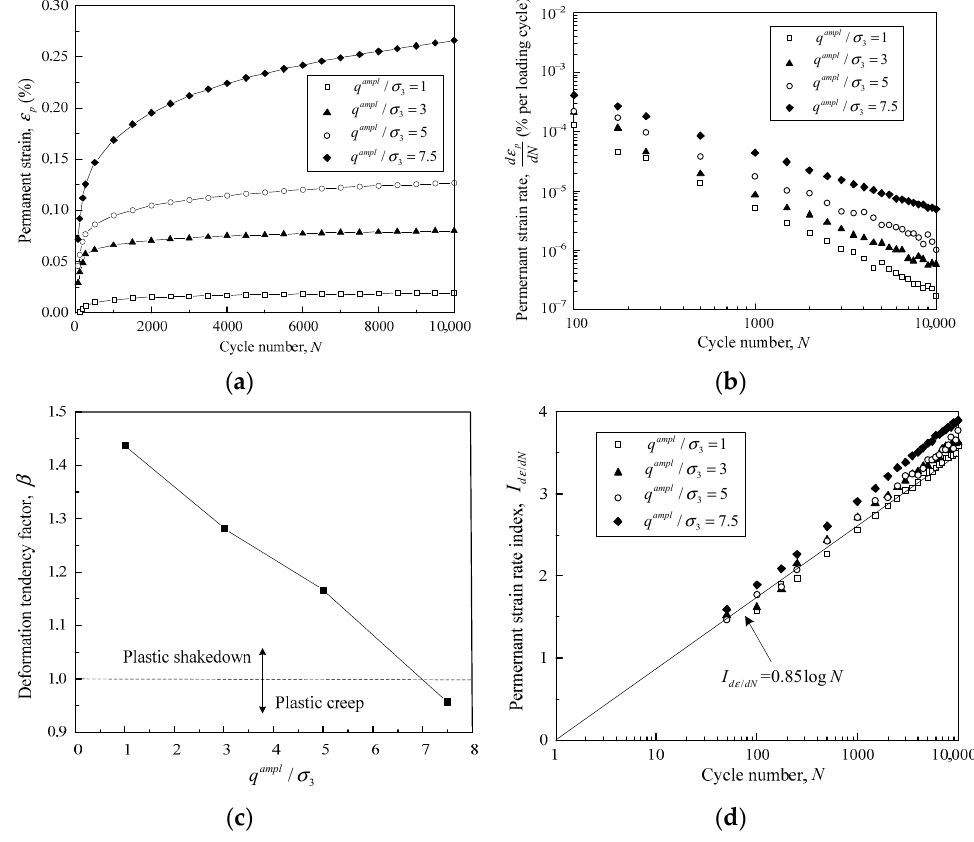
Figure 14. Permanent deformation properties of crushed tuff aggregates at optimum water content: ( a ) the relationship between permanent strain and loading cycles; ( b ) permanent strain rate plotted against loading cycles in double-log coordinate; ( c ) development of deformation tendency factor β against cyclic amplitude; ( d ) normalized strain rate curves under different cyclic amplitudes. (Data calculated from Cao et al., 2017) [7].